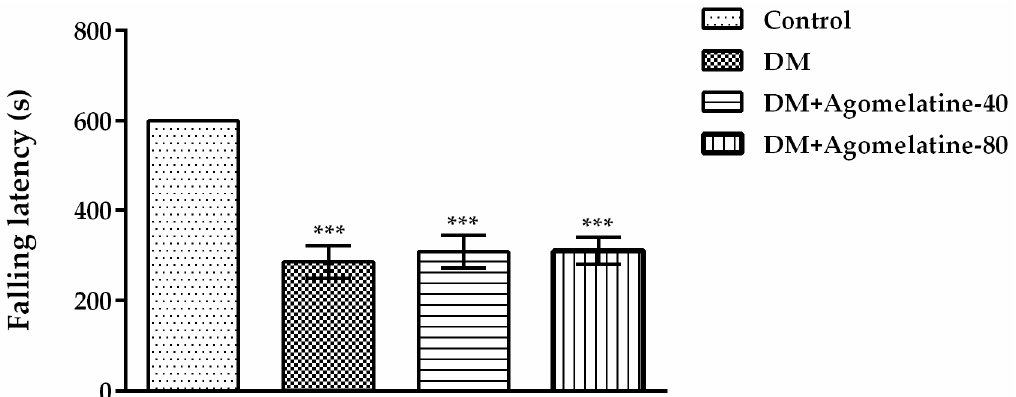
Figure 6. Falling latencies of normoglycemic rats administered saline solution (control) and diabetic rats administered saline (DM), 40 mg/kg agomelatine or 80 mg/kg agomelatine for 2 weeks, in the Rota-rod test. Values are given as mean ± S.E.M. Significant difference against control group *** p < 0.001. One-way-ANOVA, post-hoc Tukey HSD multiple comparison test, n = 8.